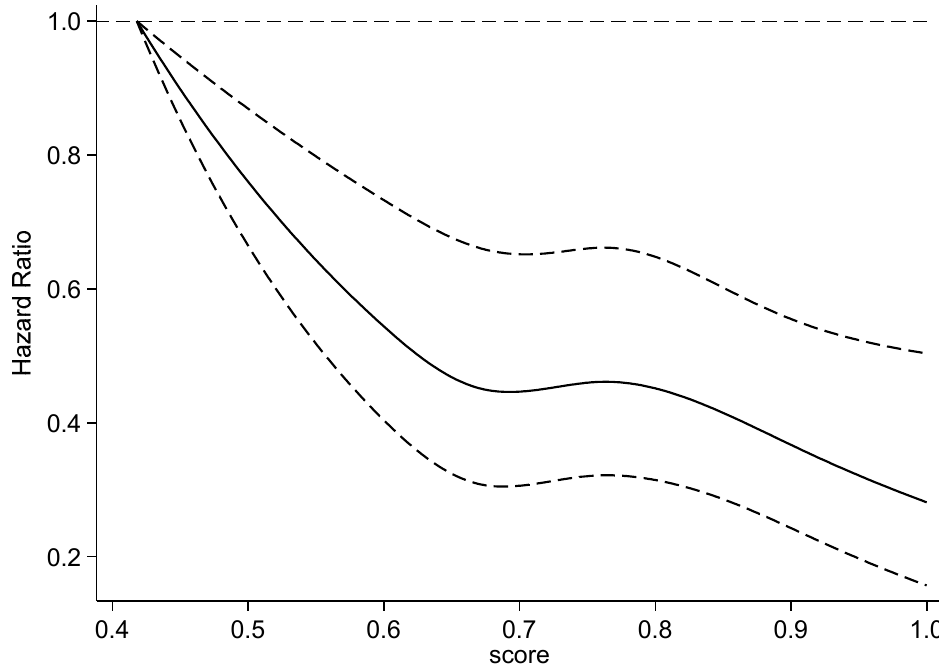
Figure 1. Dose–response relationship between the efficiency score and risk of incident hypertension .